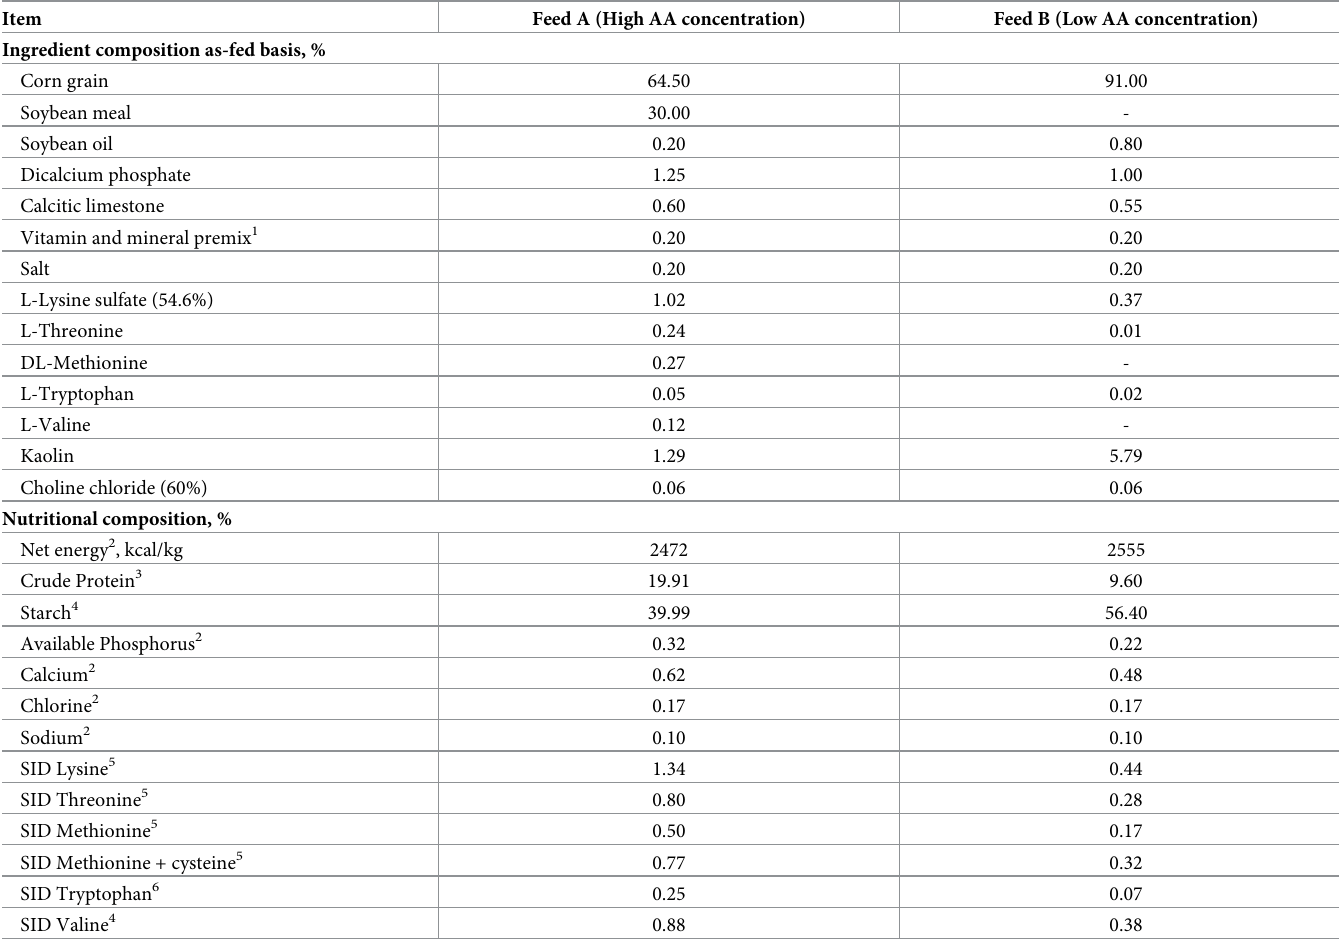
Table 1. Centesimal and nutritional composition of feeds A and